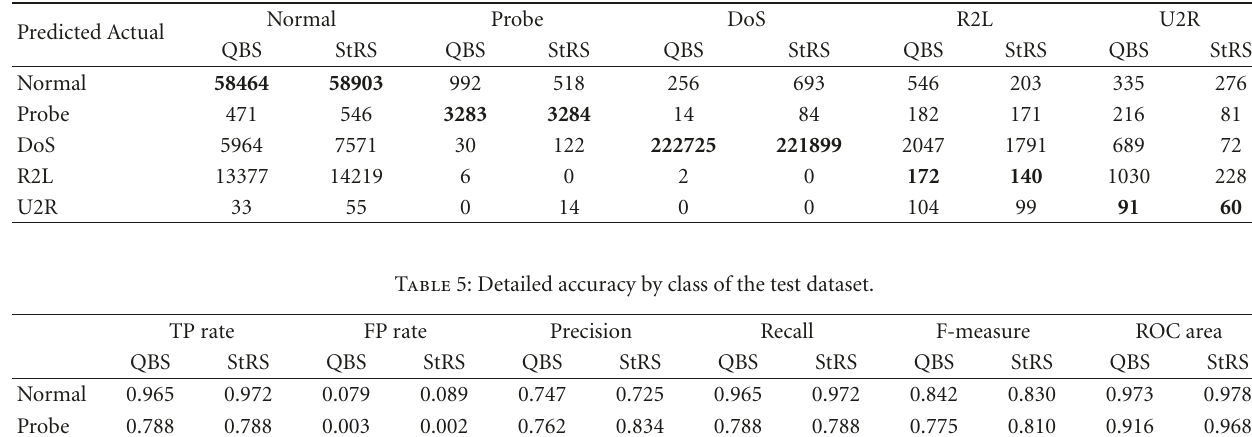
Table 4: The confusion matrix of the test dataset.